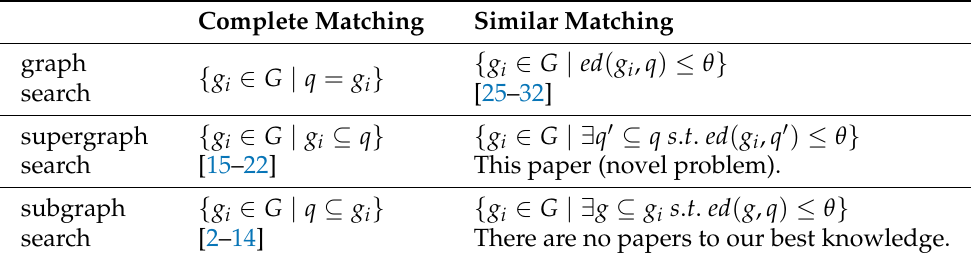
Table 1. Summary of graph search problems and